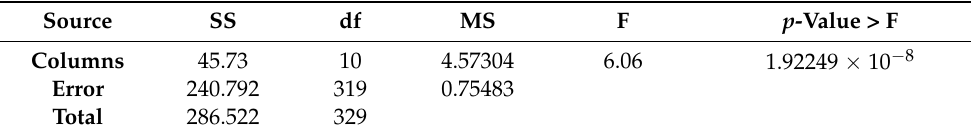
Table 3. ANOVA test results.